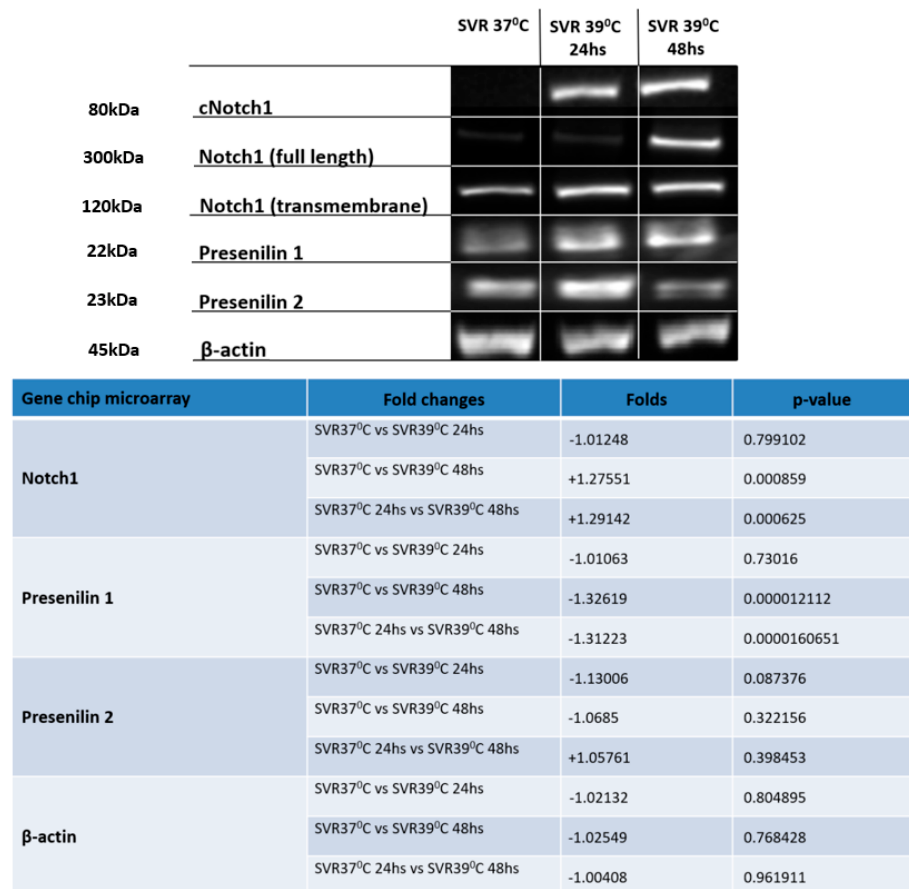
Figure 4. Western blot analysis conducted on SVR cells under 37 ◦ C and 39 ◦ C (at 24 and 48 h) for the evaluation of Notch1 and Presenilin 1 and 2. Experiments were repeated in triplicate and p -values are displayed in the lower right panel.